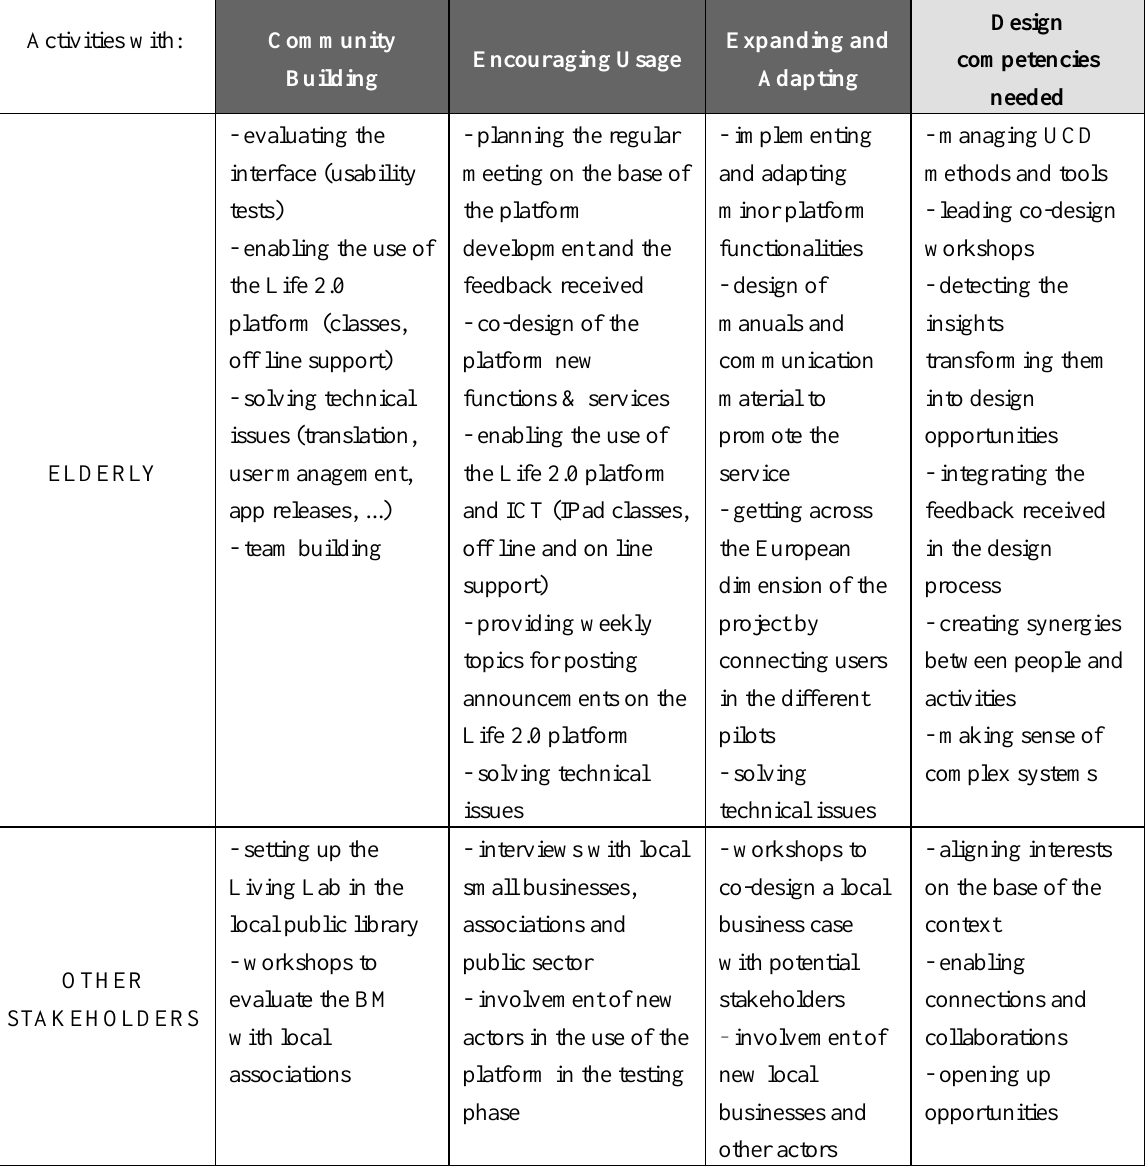
Table 1 . The activities carried out during the pilot